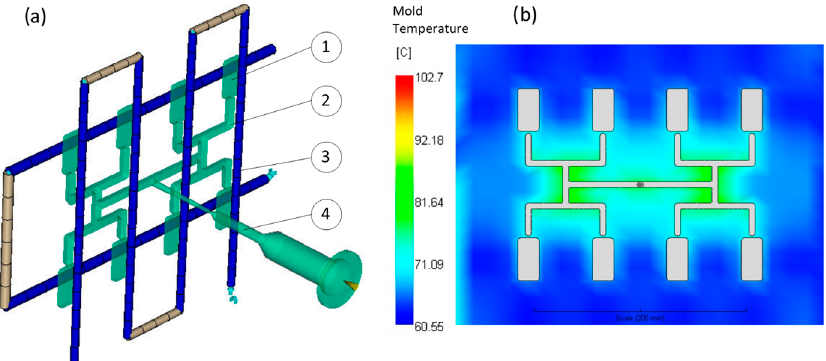
Figure 9. Simulation procedure: ( a ) simulation model: 1—cavity, 2—runners, 3—cooling channels,